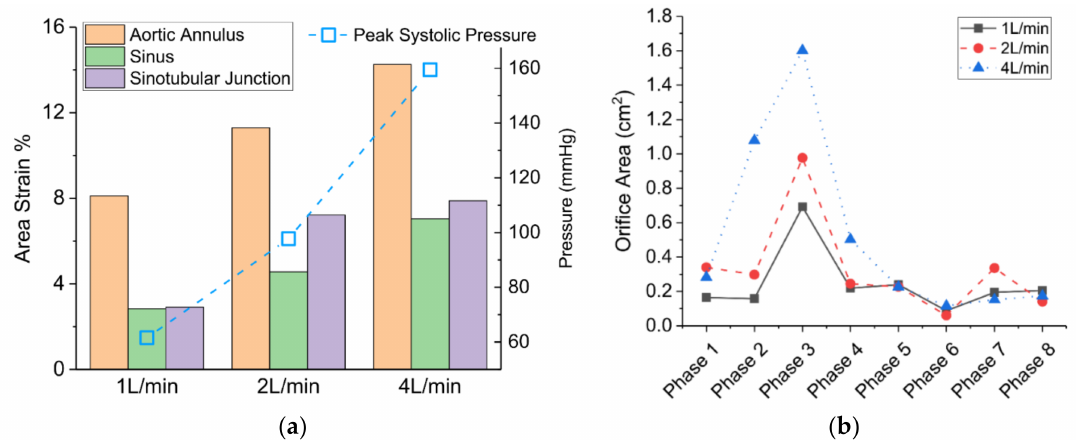
Figure 11. The structure deformation under reduced cardiac outputs. ( a ) The area strain; ( b ) geometric orifice area.